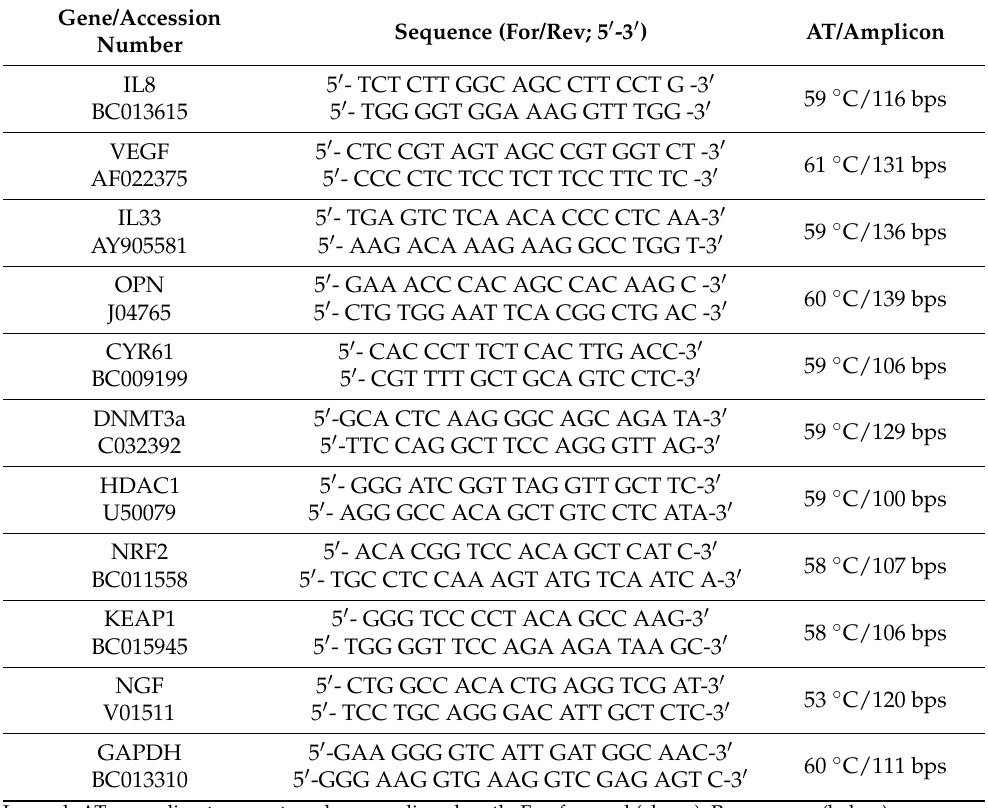
Table 1. Primers used in this study. Primer pairs were designed one intron-spanning specifically to produce an amplicon no longer than 150 bps (amplicon size). Gene direction sequences (For and Rev) were generated by prime3 software according to common parameters applied to specific mRNA complete sequences (www.ncbi.nlm.nih.gov (accessed on 25 June 2019), nucleotide section) for real-time PCR amplification. Amplification profile was as shown in the